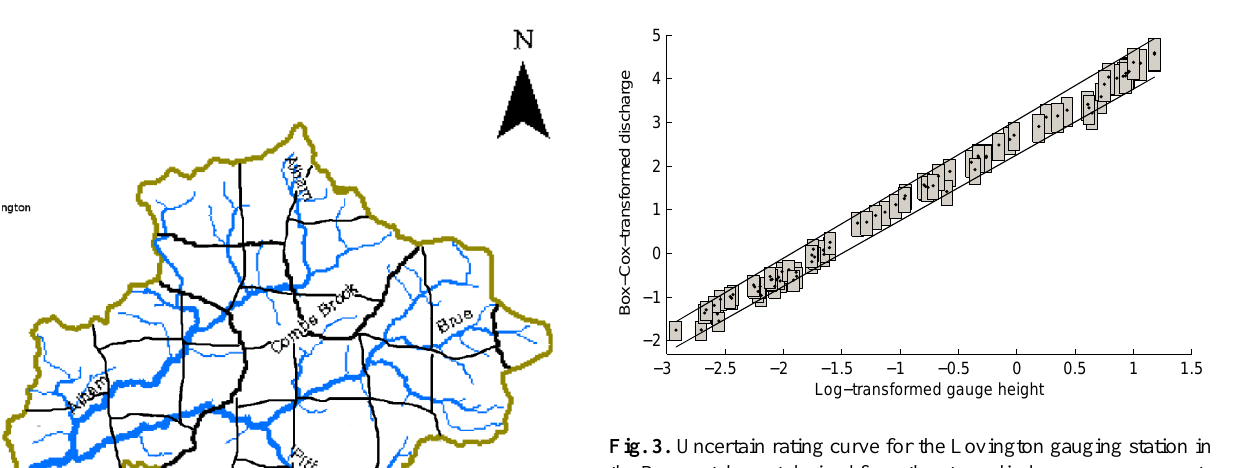
Fig. 3. Uncertain rating curve for the Lovington gauging station in the Brue catchment derived from the stage-discharge measurements from 1990–1998 (stage in m and discharge in m 3 s − 1 before trans- formation). The dots represent the measured values and the grey boxes the fuzzy representation of the estimated uncertainty in the measurements. The upper and lower lines represent the uncertainty limits for the fitted rating